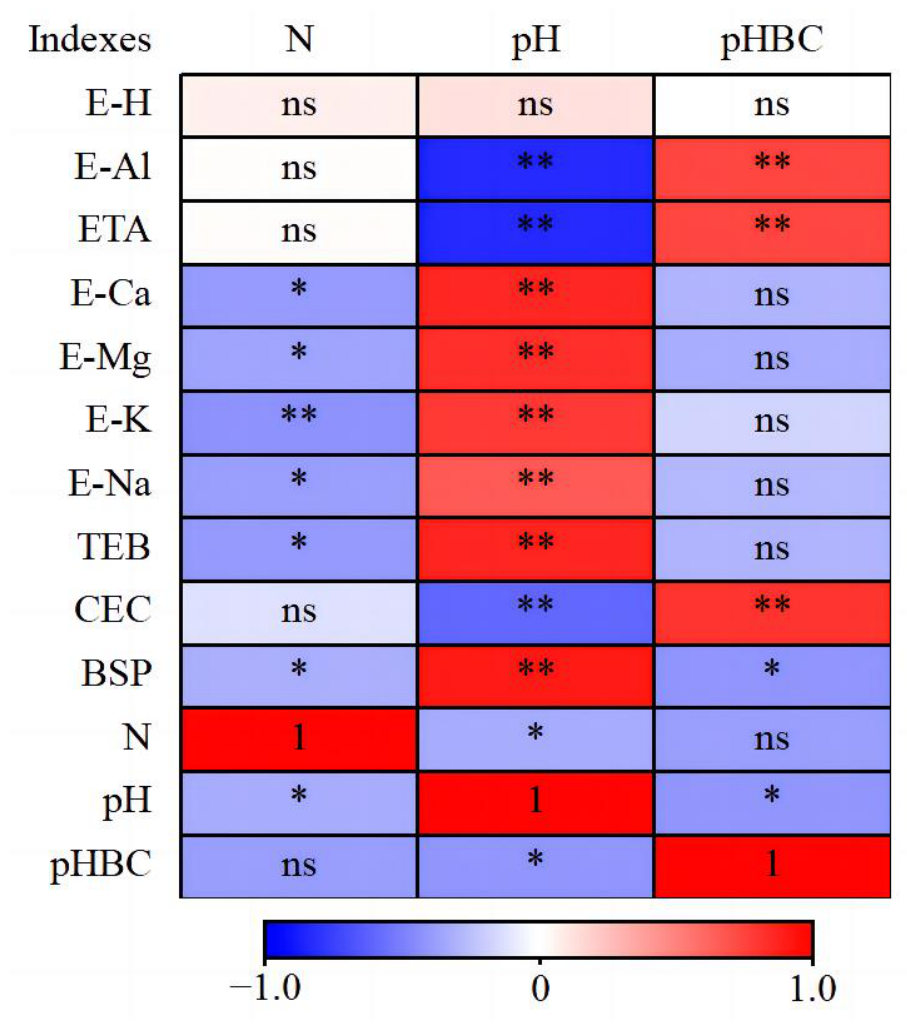
Figure 3. Correlation coefficient and path coefficient between soil exchangeable function and N application rate, pH, and pH buffer capacity. Note: ns represents no difference. * represents significance at 0.05 probability level. ** represents significance at 0.01 probability level.